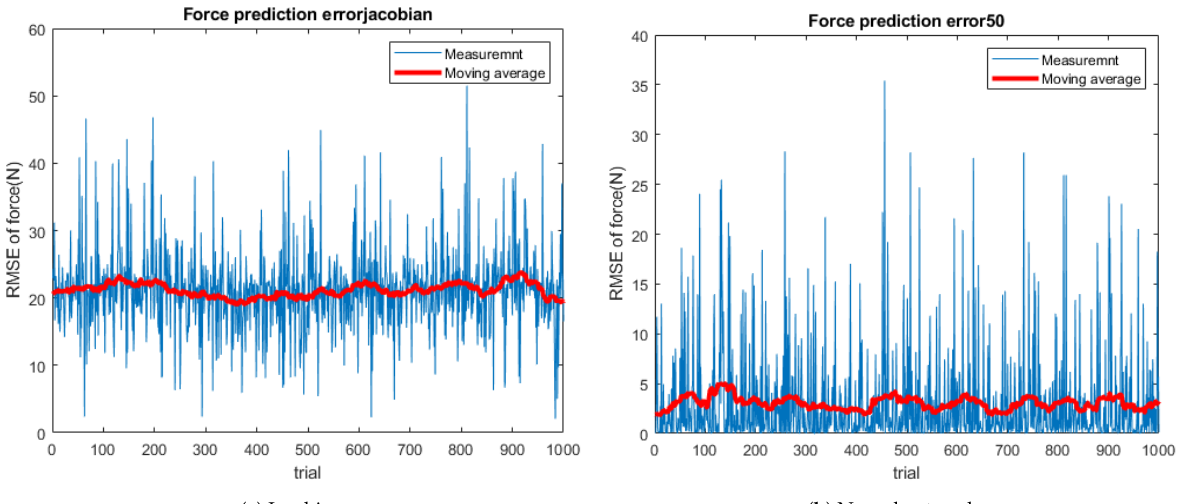
Figure 12. Force prediction error.